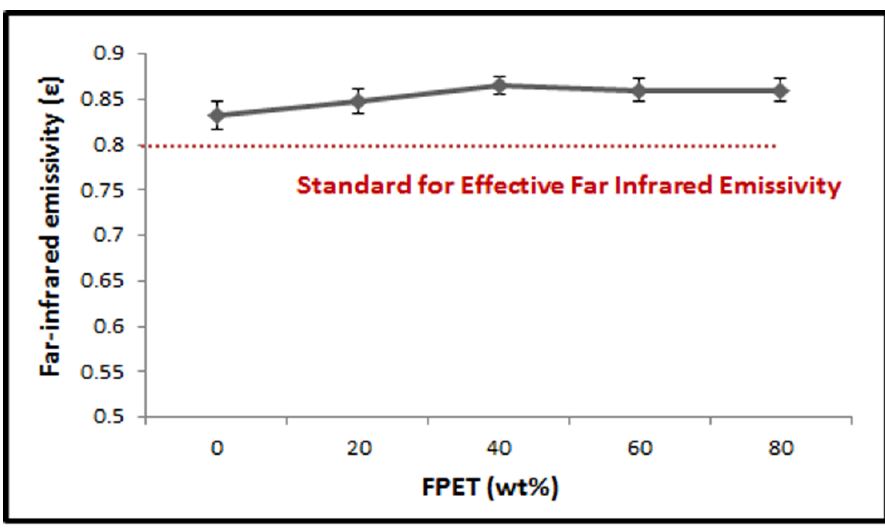
Figure 4. Far infrared emissivity of nonwoven fabrics in relation to FPET content.